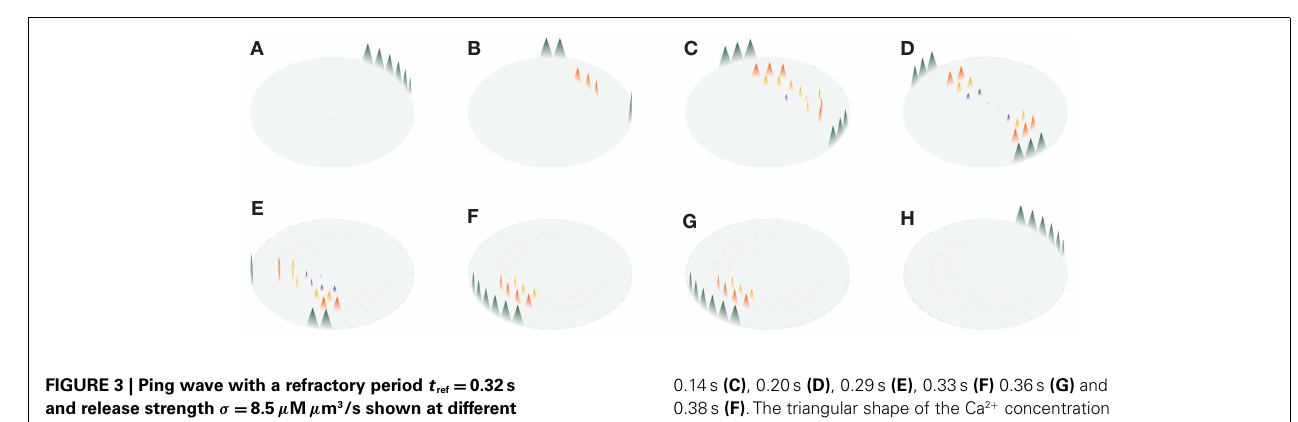
FIGURE 3 | Ping wave with a refractory period t ref = 0.32s and release strength σ = 8.5 µ M µ m 3 /s shown at different time points. The eight panels cover one revolution of the ping wave.Time increases from (A–H) as t = 0.02s (A) , 0.09s (B) ,